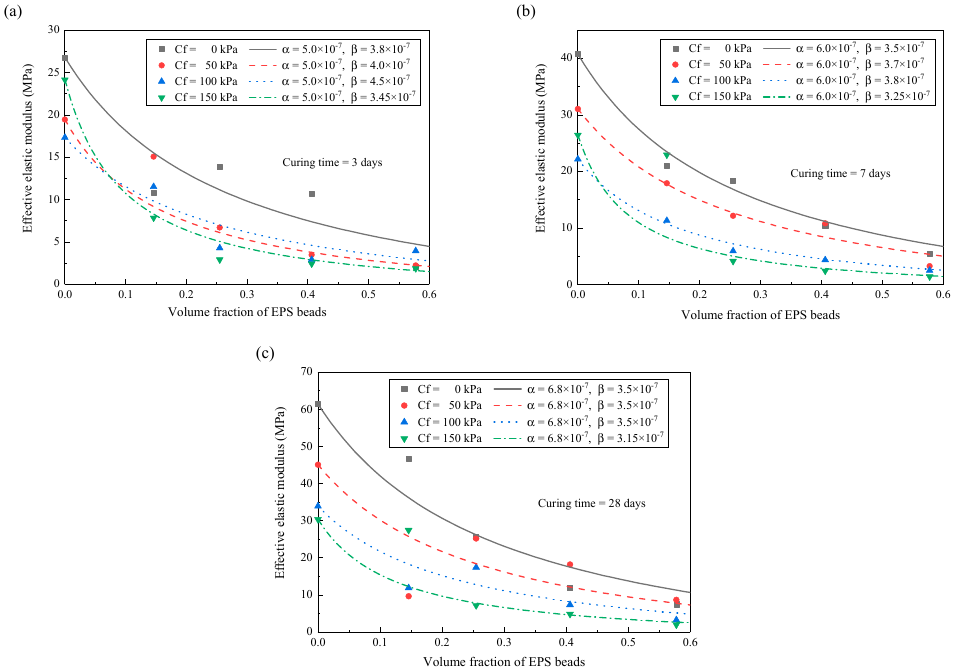
Figure 8. Variation of effective elastic modulus with volume fraction at different curing times and confining pressures ( a ) 3-days curing time; ( b ) 7-days curing time; ( c ) 28-days curing time.